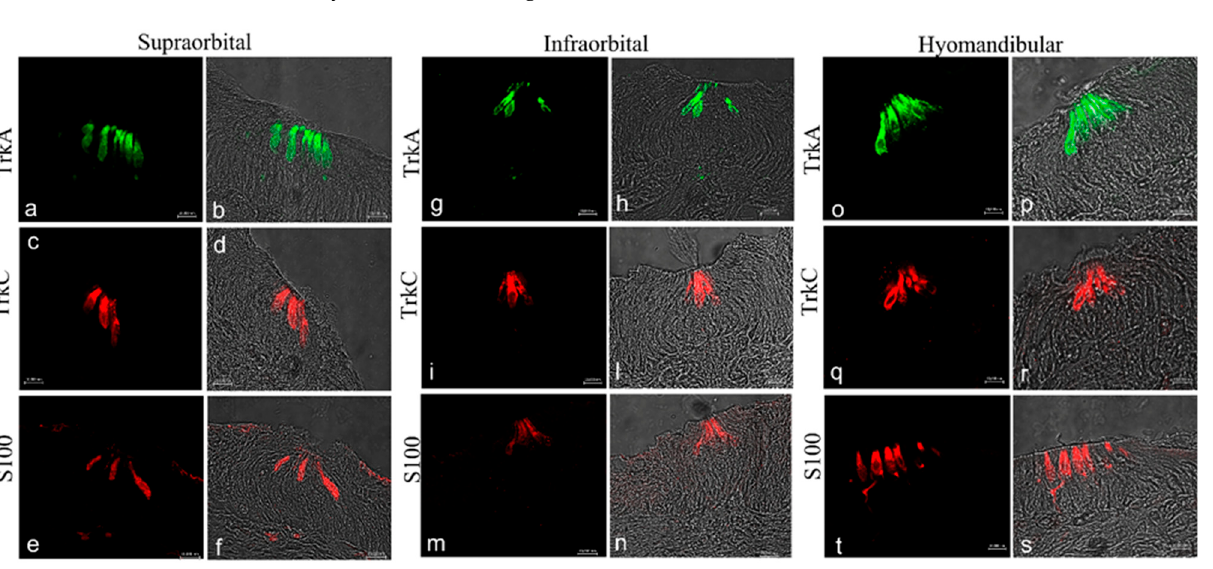
Figure 7. Lateral line system of N.guentheri head; transversal view. Immunohistochemical detection (immunofluorescence method) of TrkA, TrkC, and S100 protein. Supraorbital ( a-f ), infraorbital ( g-n ), and iomandibular free neuromast ( o-s ) in N. guentheri head show a group of sensory hair cells supported by supporting cells and laterally surrounded by long mantle cells. The hair cells in supraorbital, infraorbital, and hyomandibular free neuromast displayed cytoplasmatic im- munoreactivity for TrkA, TrkC, and S100 protein. Magnification 40X.